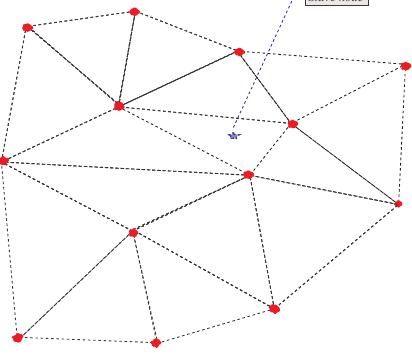
Fig. 8. 3 D diffuse contact element.